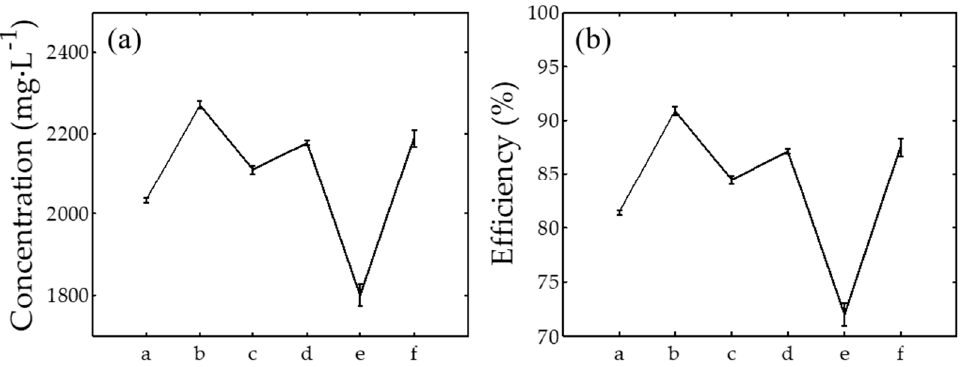
Figure 6. ( a ) Concentration of AgNPs and ( b ) their synthesis efficiency. a–f at the x-axis refer to AgNPs synthesized using Cyperus rotundus , Eleusin indica , Euphorbia hirta , Melastoma Malabathricum , Clidemia hirta , and Pachyrhizus erosus , respectively